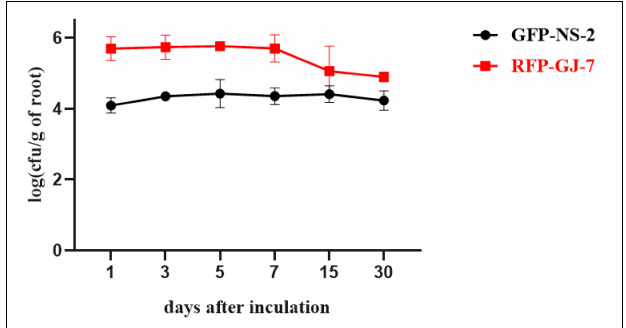
FIGURE 6 | Population of GFP-NS-2 and RFP-GJ-7 on Panax notoginseng roots. Population is expressed in log (cfu/g) of roots (y-axis) and days